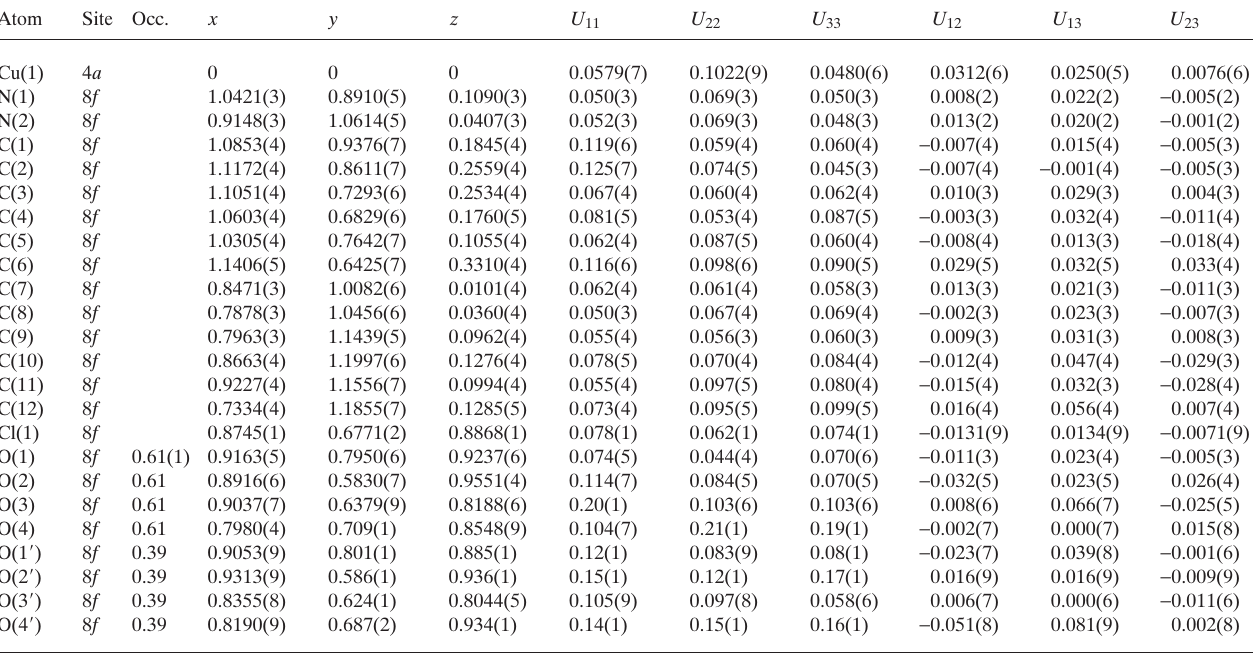
Table 3. Atomic coordinates and displacement parameters (in Å 2 ) . Atom Site